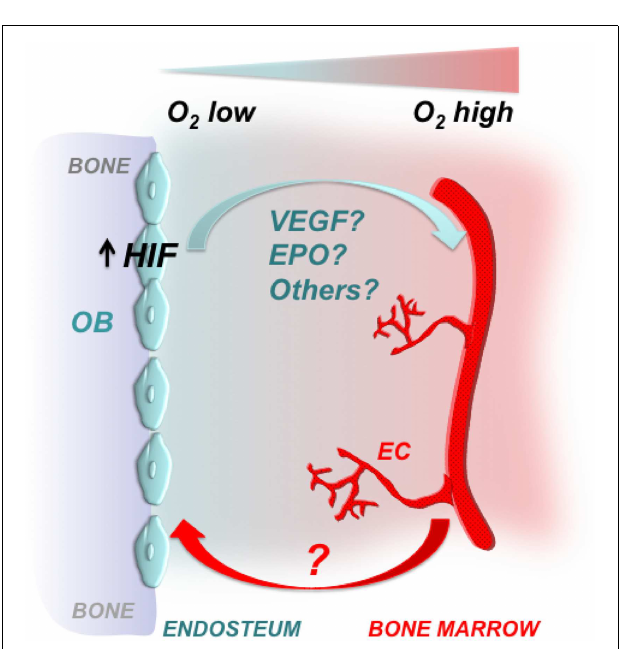
FIGURE 2 | Osteoblastic HIFs control bone marrow angiogenesis . Gradients of oxygenation are present in the bone marrow with osteoblasts at the endosteal surface of bone being among the most hypoxic areas. Osteoblasts express HIFs, which regulate osteoblast activity and angiogenesis. Some of the HIF effects on angiogenesis could be mediated byVEGF, EPO, and/or other proangiogenic factors. It has yet to be defined whether increased angiogenesis is a necessary pre-requisite for the high bone mass phenotype observed upon activation of HIFs in cells of the osteoblast lineage. OB, osteoblast; EC, endothelial